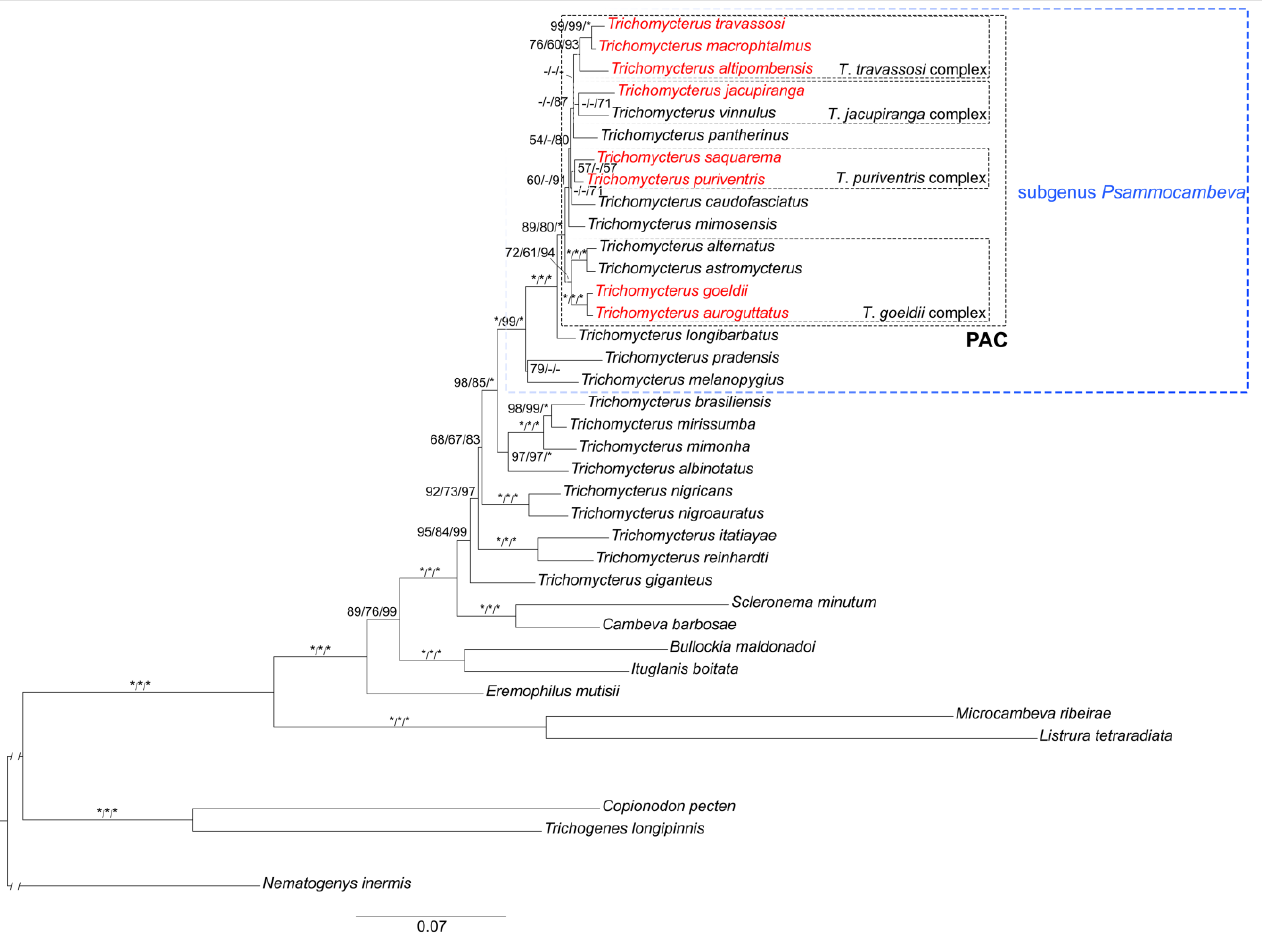
Figure 1. Maximum likelihood tree estimated by IQ-tree for 24 species of Trichomycterus and 10 out- groups, combining four genes (COI, CYTB, MYH6, and RAG2, with a total of 2974 bp). Taxa endemic to the Rio Para í ba do Sul Area are depicted in red. The numbers above branches indicate Bayesian posterior probabilities of the Bayesian inference analysis, bootstrap, and fast bootstrap values of the Maximum likelihood analyses, respectively, separated by a bar. Asterisks (*) indicate maximum support values and dashes (-) indicate values below 50. PAC, Psammocambeva